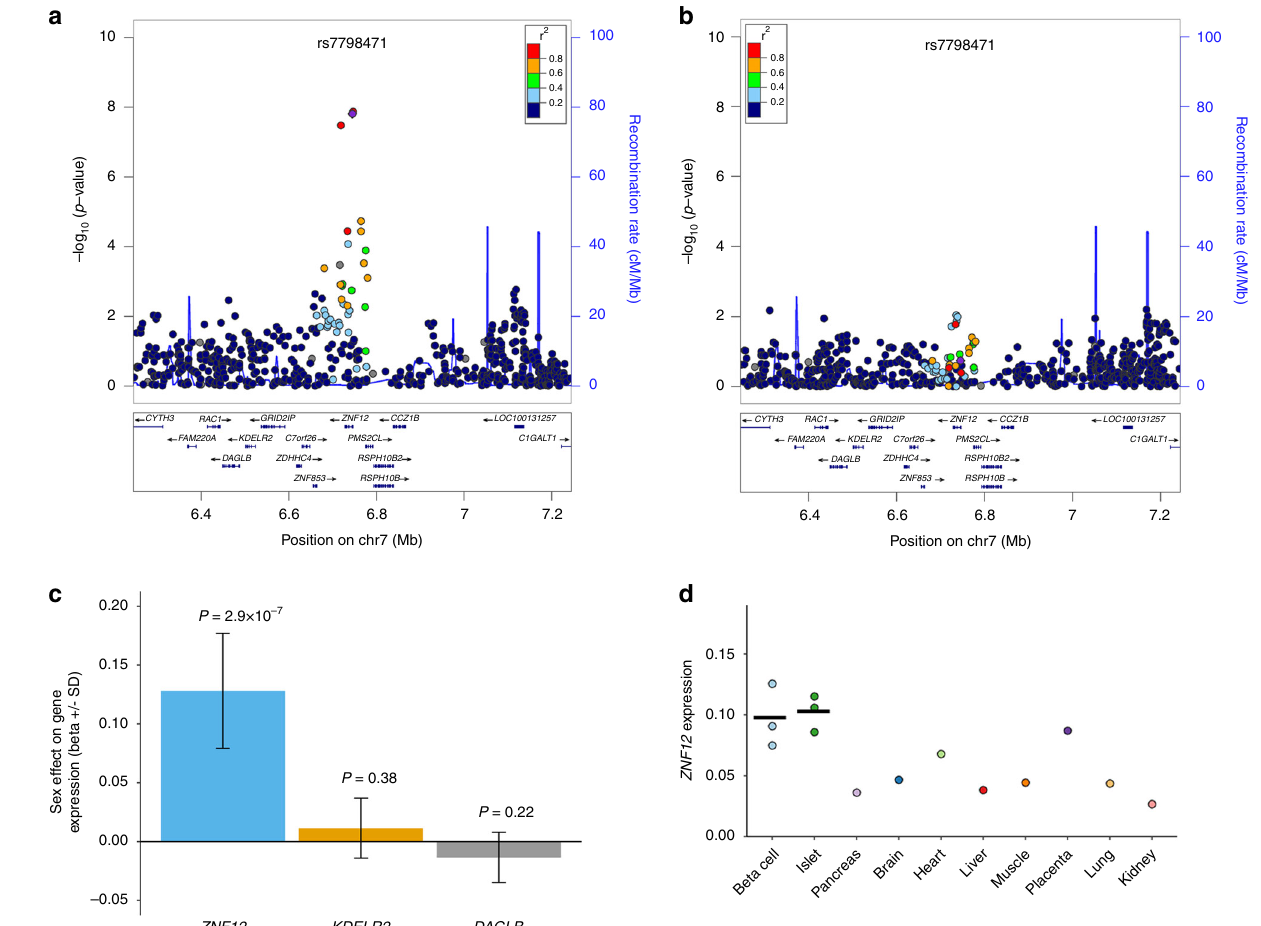
Fig. 2 Plots for ZNF12 locus with sex-dimorphic effects on FI. a female-speci fi c regional plot, b male-speci fi c regional plot, c ZNF12 whole blood RNA expression data in n = 3,621 Netherlands Twin Register and Netherlands Study of Anxiety and Depression studies. Beta ± SD (error bars) represent the sex effect in the linear regression analysis where the average gene expression by all probes in the gene was predicted by sex, as well as the following covariates: age, smoking status, RNA quality, hemoglobin, study, time of blood sampling, month of blood sampling, time between blood sampling and RNA extraction, and the time between RNA extraction and RNA ampli fi cation. A positive value represents an upregulated expression in women and a negative value an upregulated expression in men. The P value represents the signi fi cance of sex effect from the linear models ( P values are not corrected for multiple testing). d ZNF12 tissue expression relative to three housekeeping genes ( PPIA , B2M , and HPRT ). For beta cell ( n = 3) and islets ( n = 3) data, lines are means. Quantitative RT-PCR was carried out using cDNAs from three human donors (beta-cells and islets). The other tissues were commercial cDNAs (one point observed in women than men 23 . For FG, SNP rs1281962 located in the fi rst intron of the RGS17 gene revealed larger effects on FG in women ( β female = 0.014, P female = 2.6 × 10 − 7 ) than in men at nominal signi fi cance ( P sex-dimorphic = 2.2 × 10 − 7 , P heterogeneity =